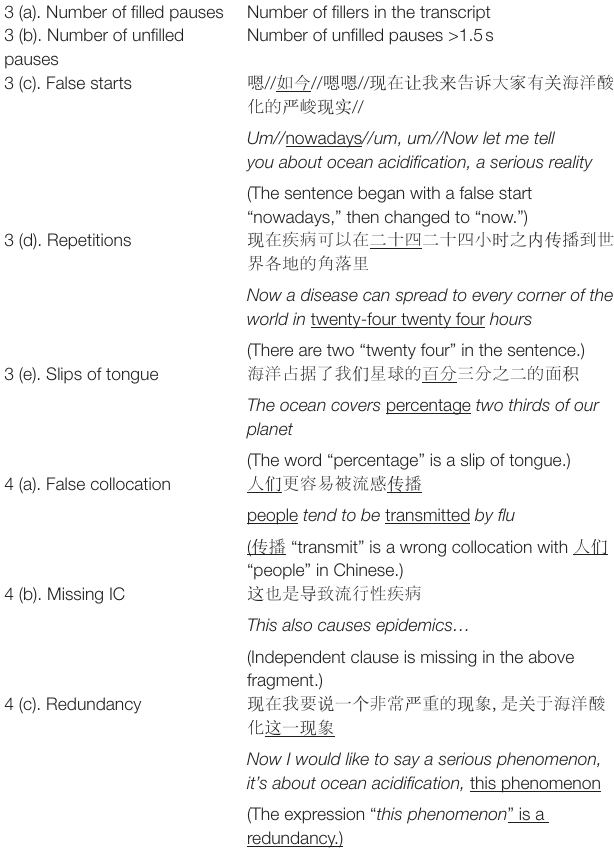
TABLE 4 | Illustration of the metrics of delivery and quality of expression.